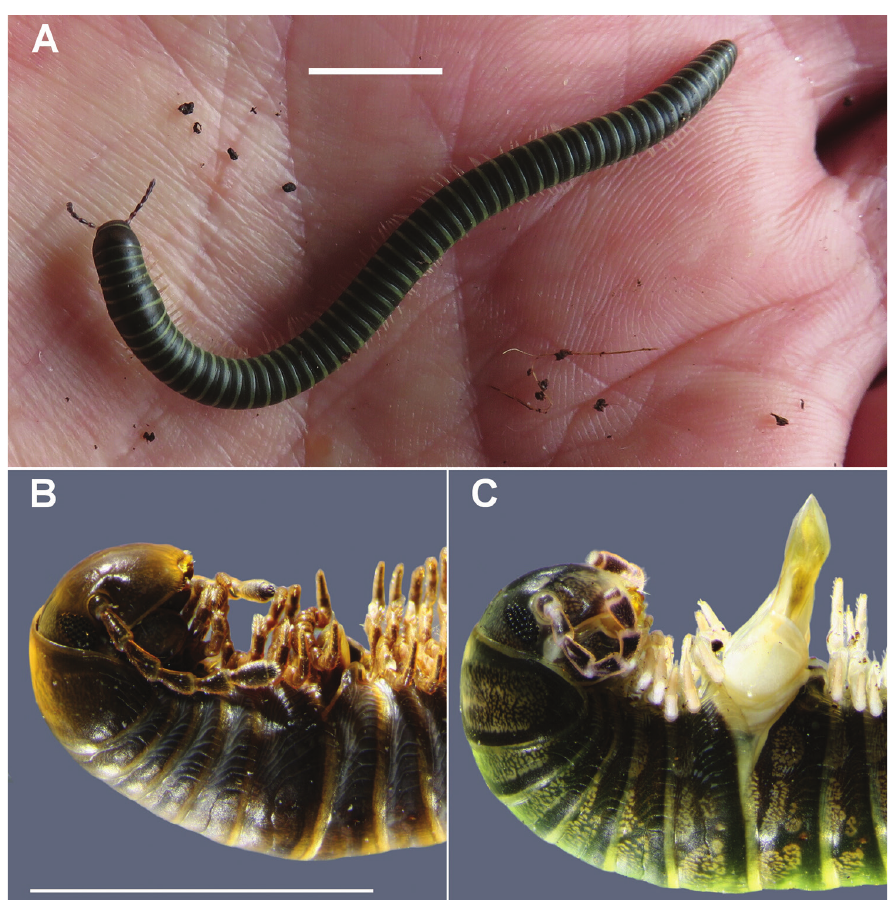
Figure 1. Amastigogonus fossuliger Verhoeff, 1944. A Living male on author’s palm, later preserved in QVM 23:54468 B Long-preserved male with retracted gonopods, ex QVM 23:54290 C Male with gonopods everted after freeze-killing and soaking in water, ex QVM 23:54468. Scale bars: A = 10 mm, B, C = 5